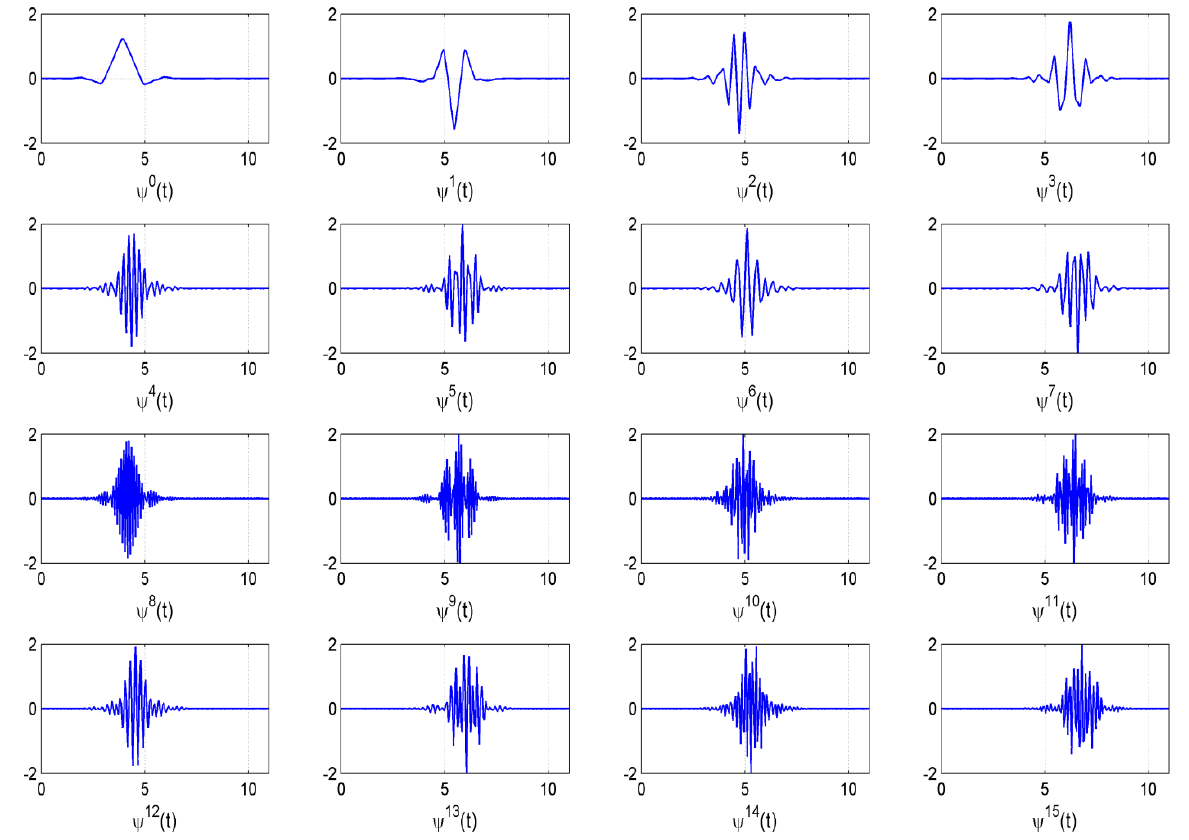
Figure 3. Templates (wavelet packets) corresponding to the 12-tap Coiflet